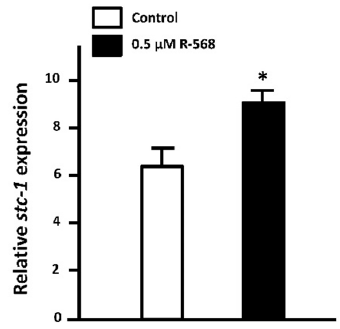
Figure 4. Effect of activated calcium-sensing receptor (CaSR) on STC-1 mRNA expression in 3-dpf zebrafish embryos. Zebrafish embryos at 3-dpf were treated with 0.5 µM R-568 (sc-361302, Santa Cruz